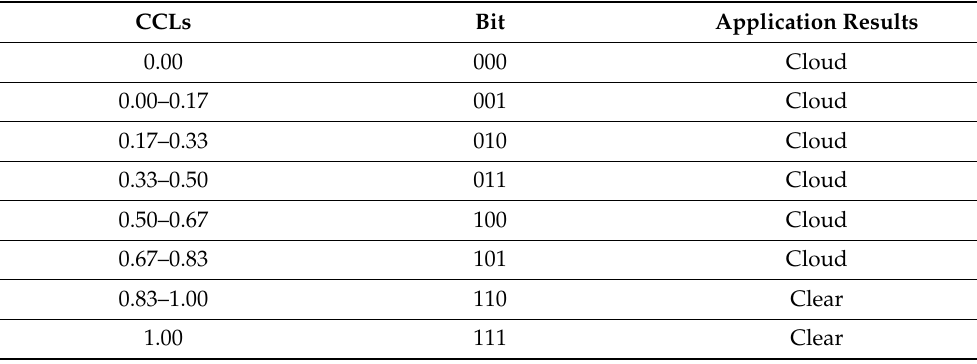
Table 7. Overall CCLs (Overall clear confidence levels) in SGLI-CLFG and simplified application results in this article.